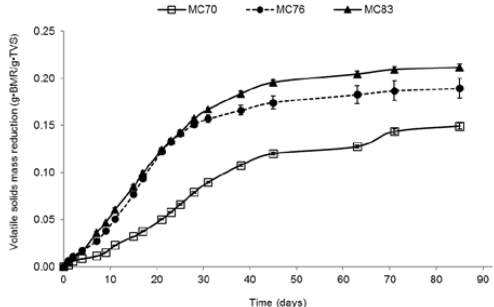
Figure 1. Cumulative volatile solids mass reduction (BMR/TVS) during solid-state anaerobic digestion (SS-AD) of dairy manure. Digesters containing non-amended manure containing 70% moisture content ( MC) (MC70) and manure amended to 76% and 83% MC (equivalent to the water holding capacity of dairy manure) (MC76 and MC83, respectively) were incubated at 37 ° C for 85 days. Values are means (±SE) of three replicates. BMR: removed biomass; TVS: total volatile solids.